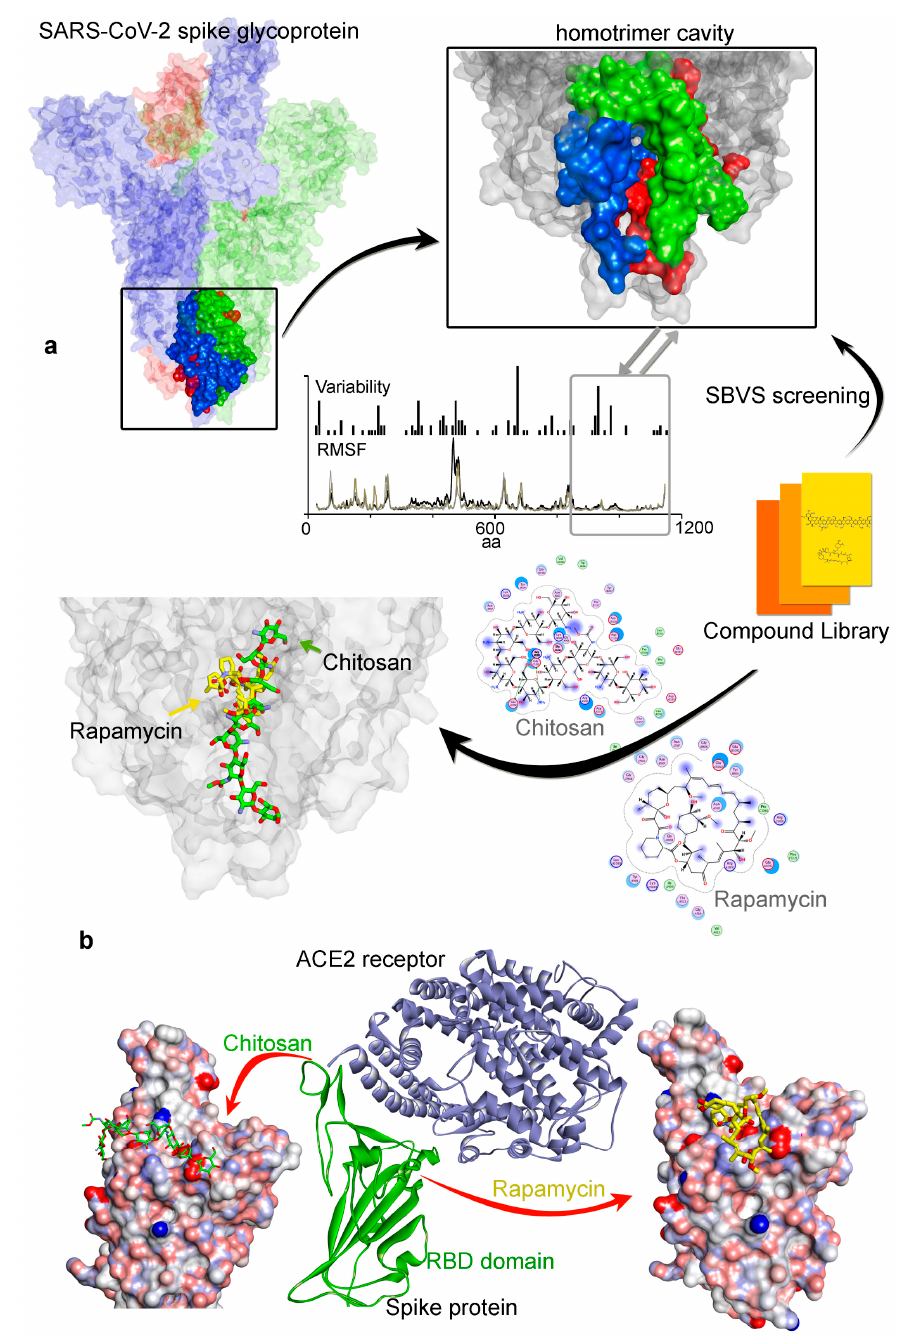
Figure 4. Targeting di ff erent pockets of the SARS-CoV-2 spike protein. ( a ) The homotrimer cavity from the SARS-CoV-2 spike glycoprotein bound to known compounds. ( b ) The ligands that were found interacting with the homotrimer cavity with high binding a ffi nity were also docked with an interface formed by the spike proteins (RBD domain; PDB ID. 6lzg [90]) that interact with the ACE2 receptor. SBVS, structure-based virtual